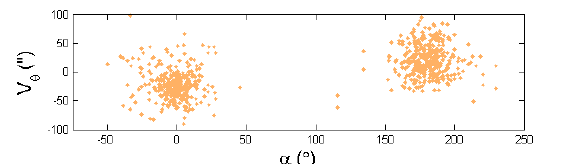
Figure 8: Horizontal angle residuals versus vertical angle plot of unmodelled 1’ collimation axis error in point-based self- calibration for panoramic scanners.